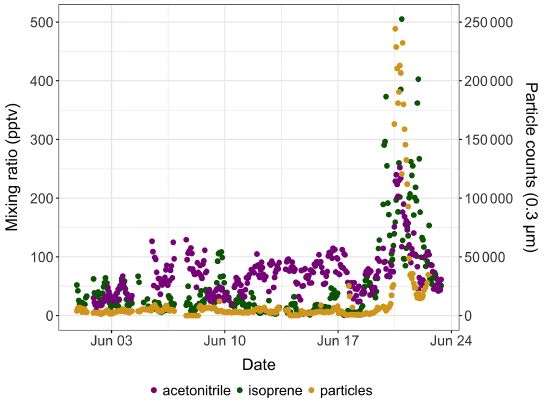
Figure 4. Time series of isoprene (green) and acetonitrile (purple) mixing ratios (in pptv) and of 0.3µm particle counts (yellow) in ambient air at Toolik Field station in June 2019.